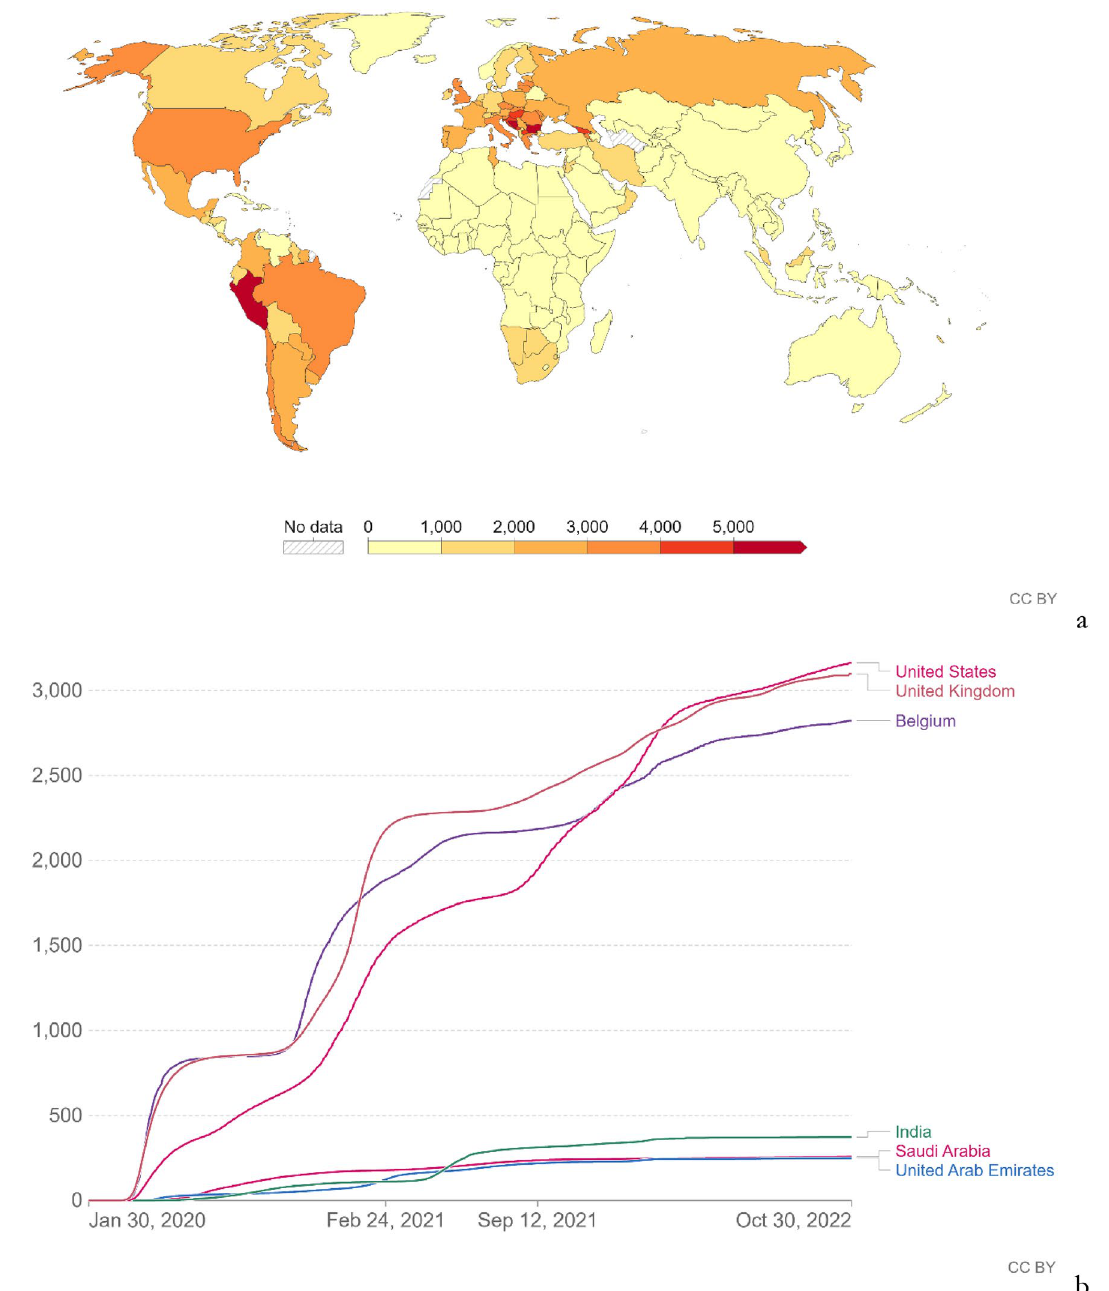
Fig. 1 a Map of cumulative COVID-19 fatalities per million peo- ple (to November 9, 2022). Image from [2]. CC BY. b Time series of cumulative COVID-19 fatalities per million people in the